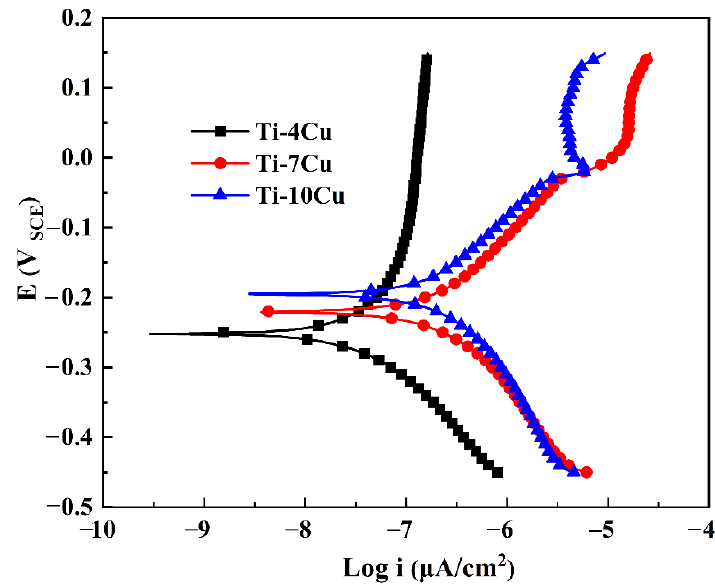
Figure 10. Polarization curves of the as-cast Ti-xCu alloys in SBF solution. Table 5. Electrochemical parameters of the as-cast Ti-xCu alloys.